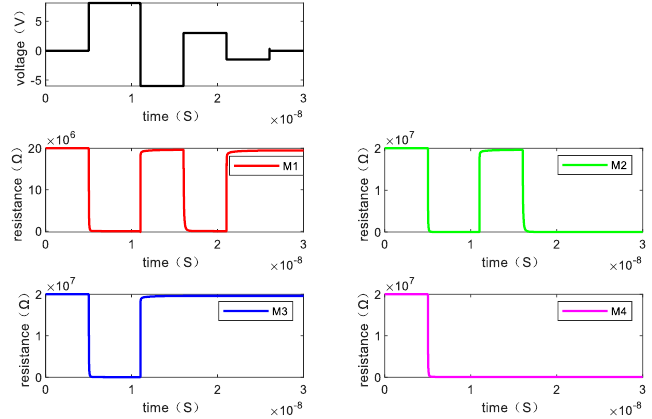
Figure 15. The changes of resistance value of each memristor when writing